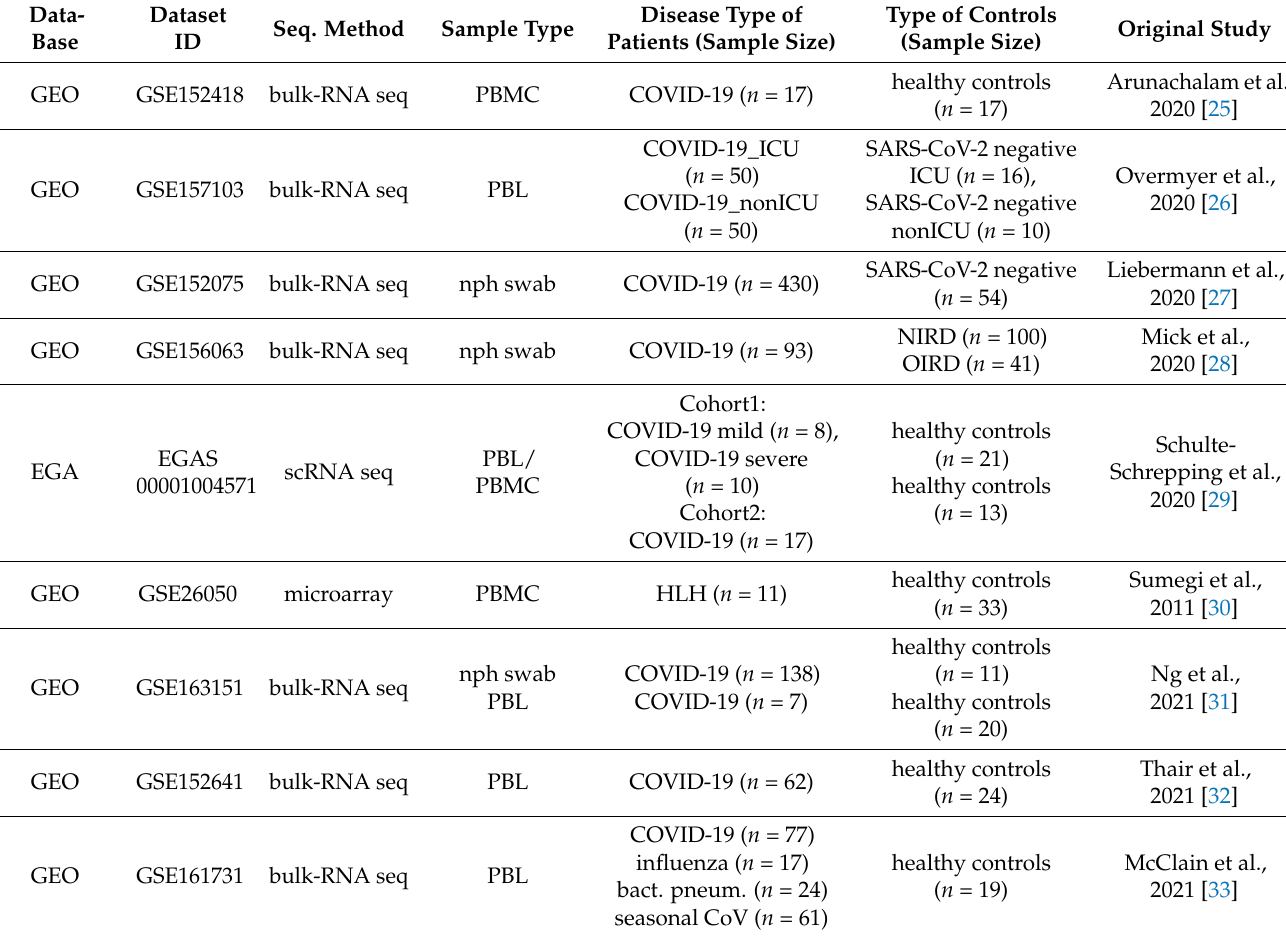
Table 1. Dataset Information and sample size used for transcriptome